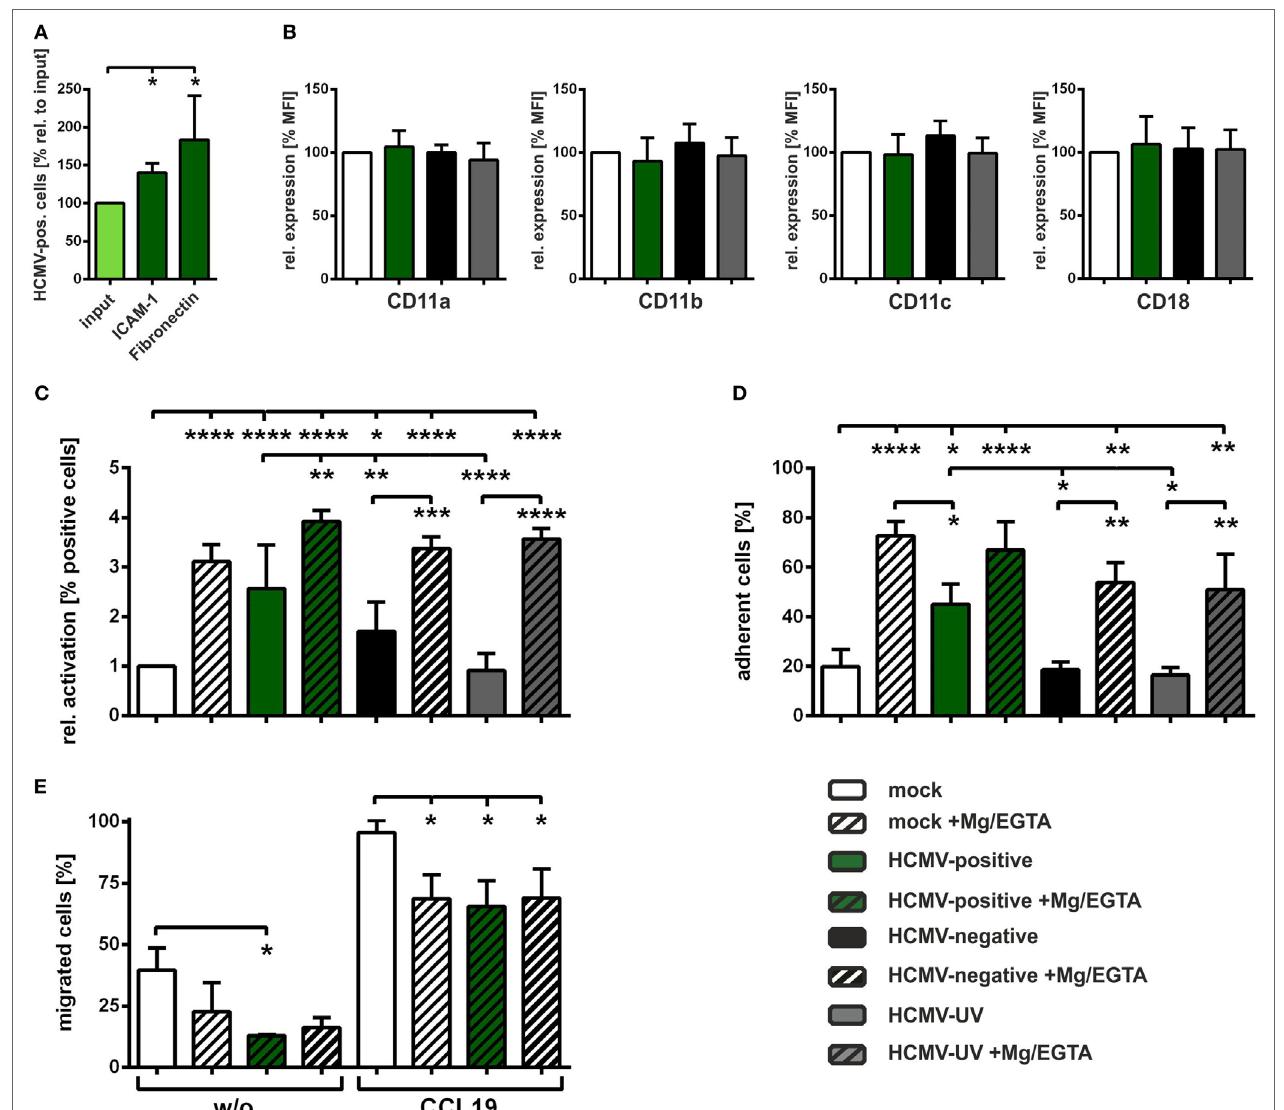
FigUre 3 | human cytomegalovirus (hcMV) increases activation of β 2-integrins thereby inducing mature Dcs (mDcs) adhesion and reducing mDc transwell migration . (a) Mature dendritic cells (DCs) were HCMV-infected and subjected to ICAM-1 or fibronectin adhesion assays 24 hpi. Infection rates were determined before adhesion (input condition, light green bar) and after ICAM-1 ( n = 5) or fibronectin ( n = 3) adhesion (green bars). Infection rate before adhesion (input) was set to 100% and relative changes of infection rates in the adherent fractions are shown. (B) Mock-, HCMV-, or HCMV-ultraviolet (UV)-infected mDCs were harvested 24 hpi, stained with antibodies specific for CD11a/b/c or CD18 and analyzed via flow cytometry. Uninfected mock cells (white bar) were set to 100% and relative expression as mean fluorescence intensity for HCMV-positive (green bars), HCMV-negative (black bars), and HCMV-UV-infected (gray bars) mDCs are shown ( n = 3). (c) Mock-, HCMV-, or HCMV-UV-infected mDCs were harvested 24 hpi and treated with (striped bars) or without Mg/EGTA (filled bars). Subsequently, cells were stained with an antibody specific for an epitope specifically present on activated CD11/CD18 ( β 2) integrins and subjected to flow cytometric analyses. Mock (white bar) was set to “1,” and relative activation is shown for the indicated conditions. The experiment was performed at least three times with cells of different healthy donors. (D) Mature DCs were infected and treated with (striped bars) or without Mg/EGTA (filled bars) as described in (c) and subjected to fibronectin adhesion assay. Percentages of adherent cells are depicted for each condition ( n = 3). (e) Mock- or HCMV-infected mDCs (24 hpi) were treated with Mg/EGTA (striped bars) and subjected to transwell migration assays. For induction of chemotaxis, CCL19 (100 ng/ml) was added to the lower wells, while spontaneous migration without chemokine was analyzed as control (w/o). Migration was evaluated after 2 h. The percentages of migrated mDCs were calculated in the lower well by determining cell number and infection rates of migrated cells in relation to the respective starting condition. Untreated mock cells are depicted as control (white bars). The experiment was performed with cells of three different healthy donors. Only significant changes (**** = p < 0.0001; *** = p < 0.001; ** = p < 0.01; * = p < 0.05) are marked by